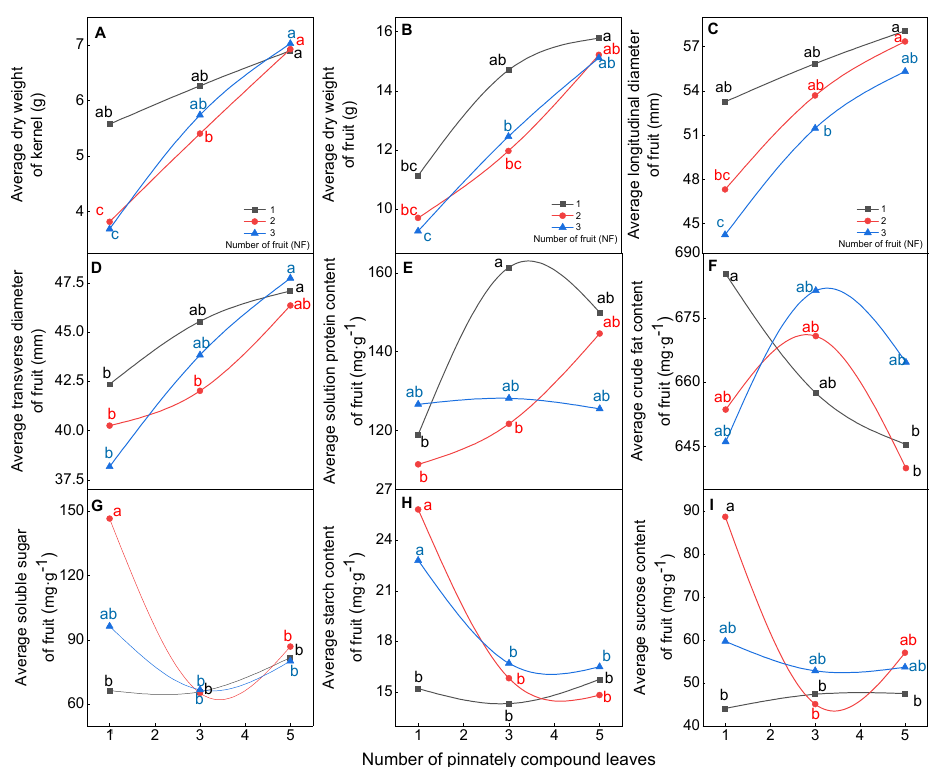
Figure 2. Effect of the source–sink relationship on the physical and chemical quality of fruit. Different lowercase letters indicate significant ( p < 0.05) differences between branches with different leaf-to-fruit ratios.